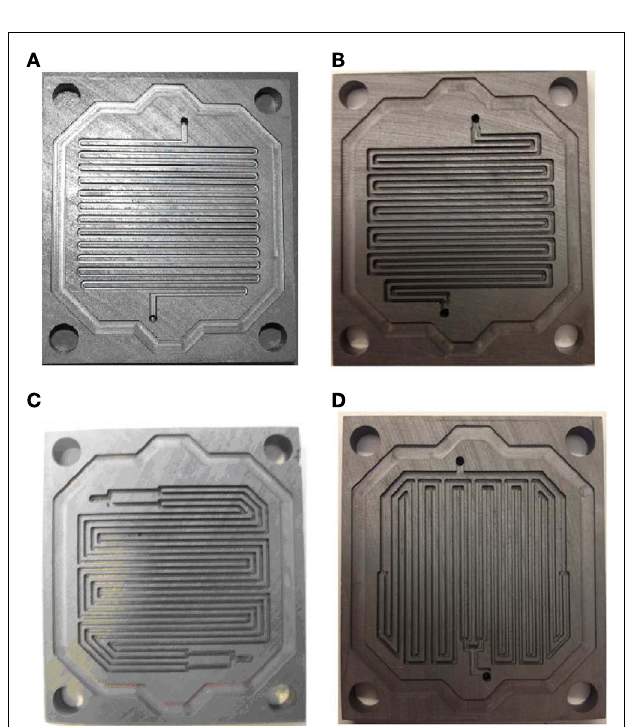
FIGURE 9 | Four types of serpentine flow channels: (A) a single serpentine channel; (B) double serpentine flow channels; (C) four serpentine flow channels; and (D) a symmetric arrangement of four serpentine flow channels